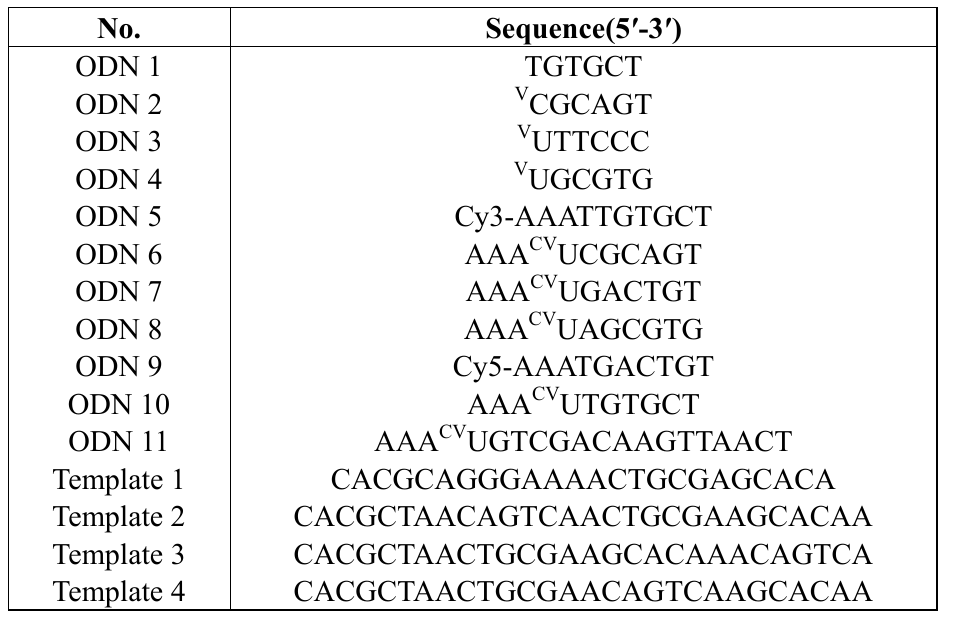
Table 1. Sequence of using